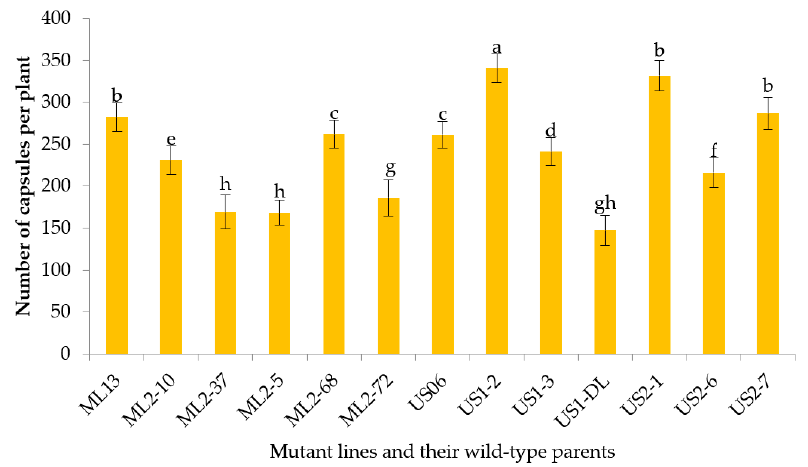
Figure 7. Number of capsules per plant (NCP) in 11 sesame mutant lines and their two wildtypes (US06 and ML13). The superscript letters represent the groups according to Duncan’s test.